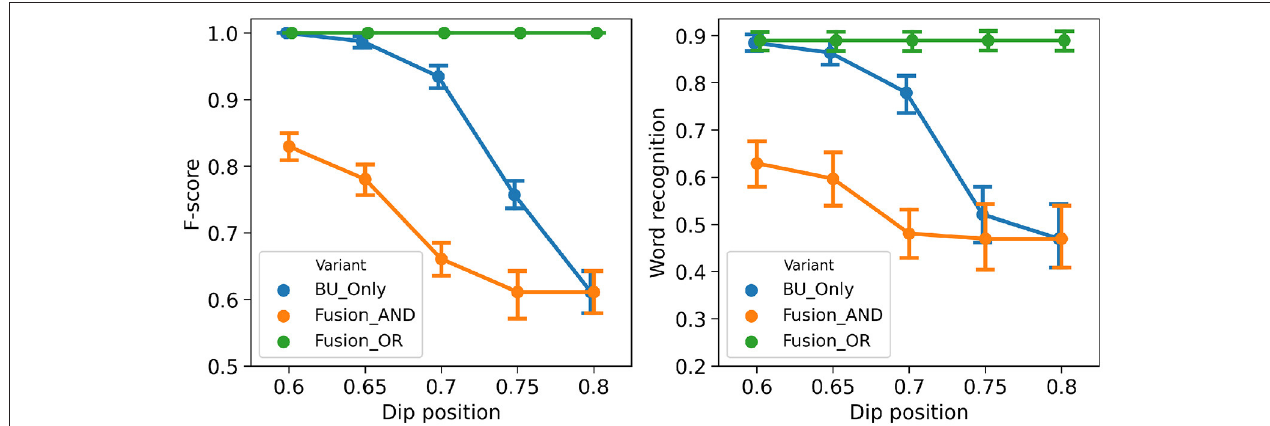
FIGURE 10 | Performance of the three variant models in the “hypo-articulation-event” condition. (Left) : F-score ( y -axis) as a function of the severity of degradation ( x -axis). (Right) : word recognition probability ( y -axis) as a function of the severity of degradation ( x -axis). Severity of degradation is measured with the minimal value attained in the loudness dip at syllable boundaries (“dip position” in plot labels; 0.6 corresponds to a well-marked dip, 0.8 removes the loudness dip altogether). Every data point is averaged, over 21 words, and over 10 independent simulations with different randomly drawn